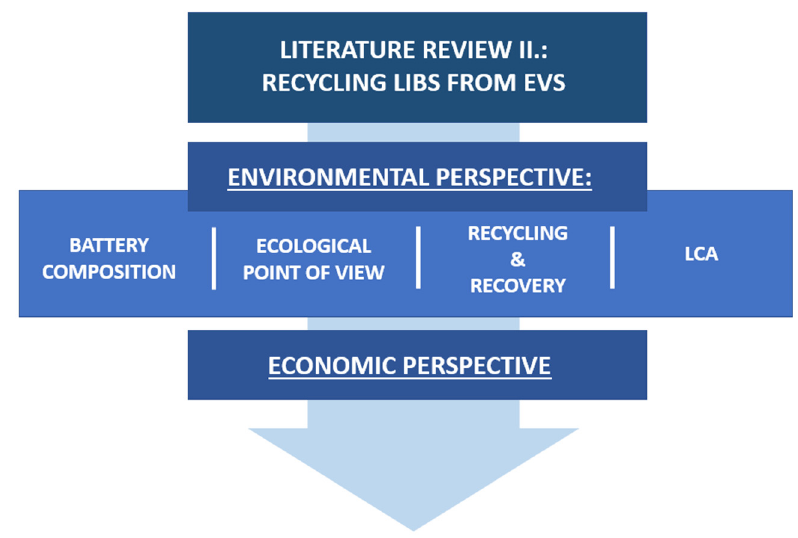
Figure 2. Methodology of the work devoted to E&E of the recycling LIBs from EVs.